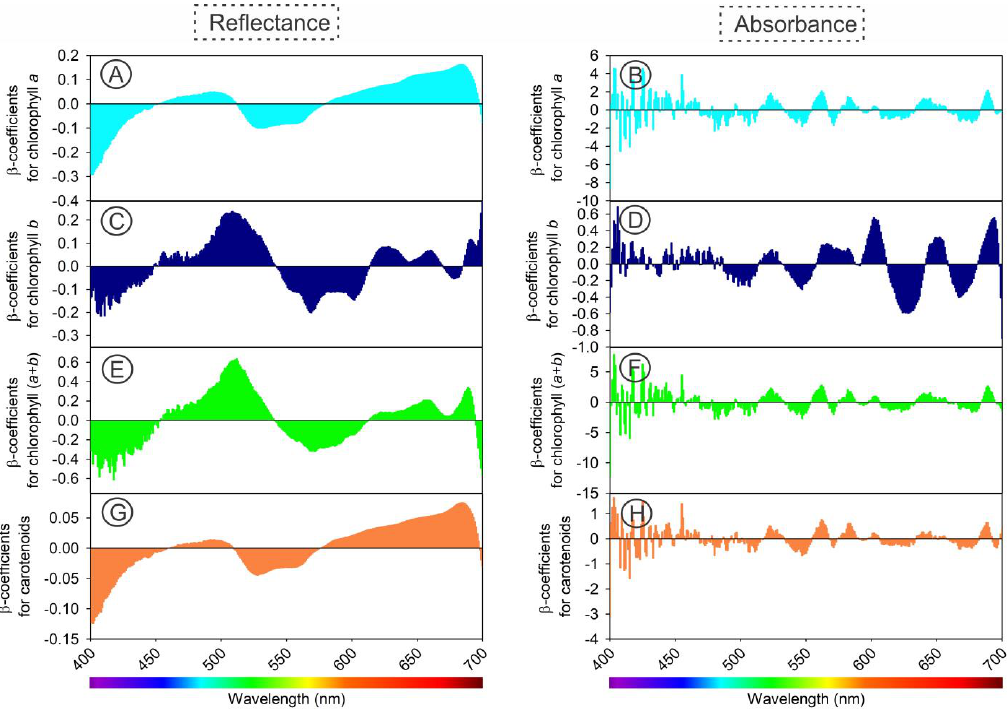
Figure 9. Regression coefficients of the PLSR model for ( A , B ) chlorophyll a (Chl a ), ( C , D ) chlorophyll b (Chl b ), ( E , F ) chlorophyll a + b (Chl a + b ), and ( G , H ) carotenoids (Car). Reflectance ( A , C , E , G ) and absorbance ( B , D , F , H ) data. ( n = 150). Table 1. Statistical metrics from the PLSR model in the calibration, cross-validation, and predicted phases. Pearson correlation (r), model goodness-of-fit (R 2 ), slope, offset, root mean squared error (RMSE), ratio of performance to deviation (RPD) and ad Bias to base models (a prediction using an independent sample coupled to calibrated models), parameters of chlorophylls and carotenoids, parameters from reflectance (single sensor), and absorbance (two sensors) hyperspectral data of tobacco leaves. The bold numbers represent statistically significant PLSR parameters.